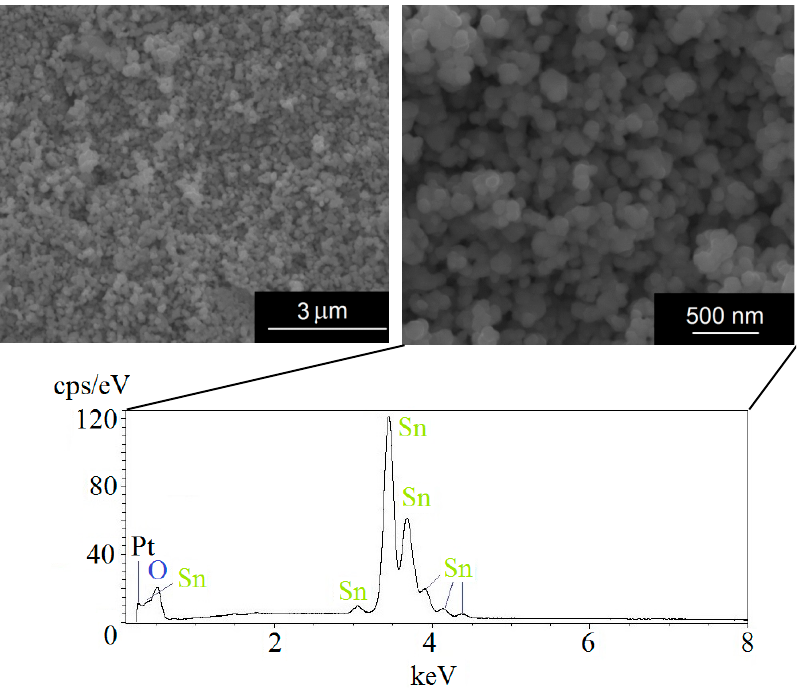
Figure 3. ( Above ) SEM micrographs showing the homogeneity of particles regarding shape and size. ( Below ) electron dispe ( Below ) electron dispersive spectroscopy (EDS) analysis spectrum of the 500 nm region for the SnO 2 sample doped with 1.4% Cd. Crystals 2019 , 9 , x FOR PEER REVIEW